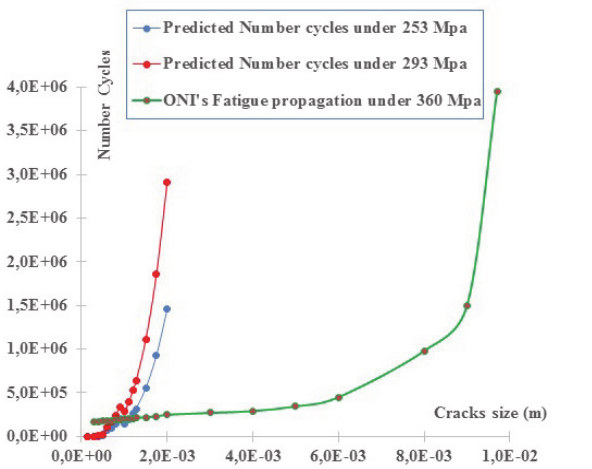
Figure 4: Number cycles for small crack and Oni’s long crack for 30NCD16